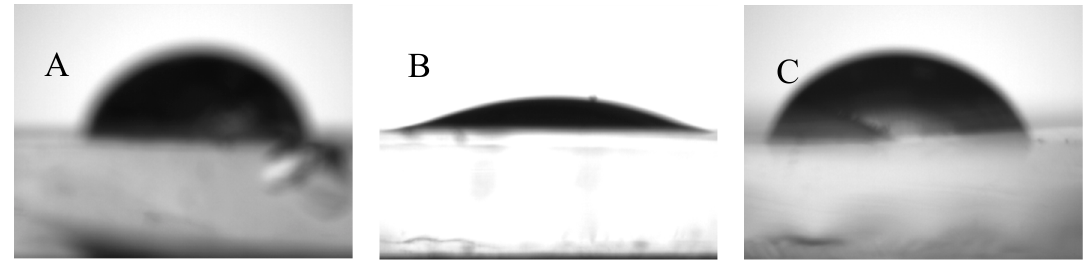
Figure 7. The contact angle of annealed BiOI at different temperatures ( A-C ): 100 °C, 300 °C, and 550 °C.